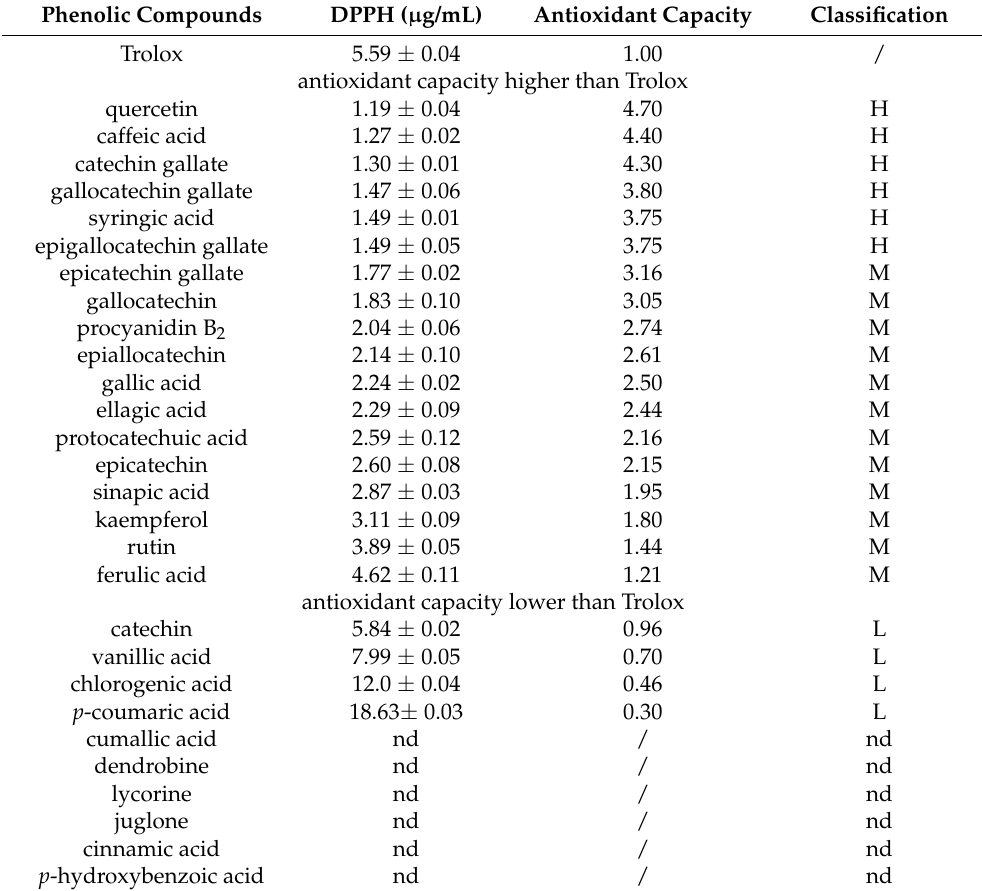
Table 3. The DPPH scavenging capacity of monomer phenolic